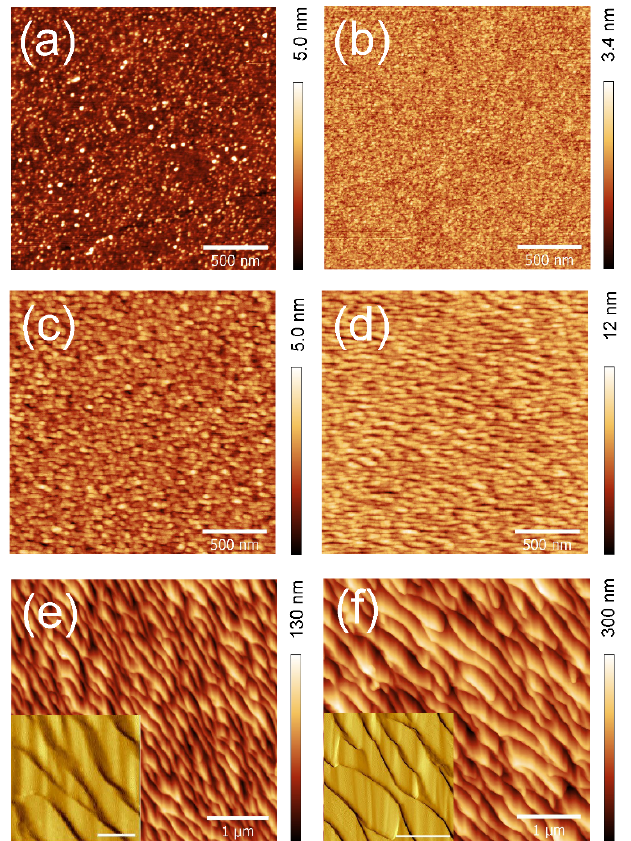
Figure 1. Atomic force microscopy (AFM) images of ZnO samples irradiated at 60 ◦ for di ff erent Ar fluences: ( a ) virgin, ( b ) 10 16 , ( c ) 10 17 , ( d ) 2 × 10 17 , ( e ) 10 18 , ( f ) 2 × 10 18 cm − 2 . The ion beam direction runs vertically from the bottom of the images. The insets of ( e , f ) show zoomed regions where the derivative along the x-axis was performed in order to highlight the tiny elongated structures aligned along the ion beam direction on the ripple structures. The horizontal bars indicate 200 nm and 500 nm in ( e , f ), respectively.